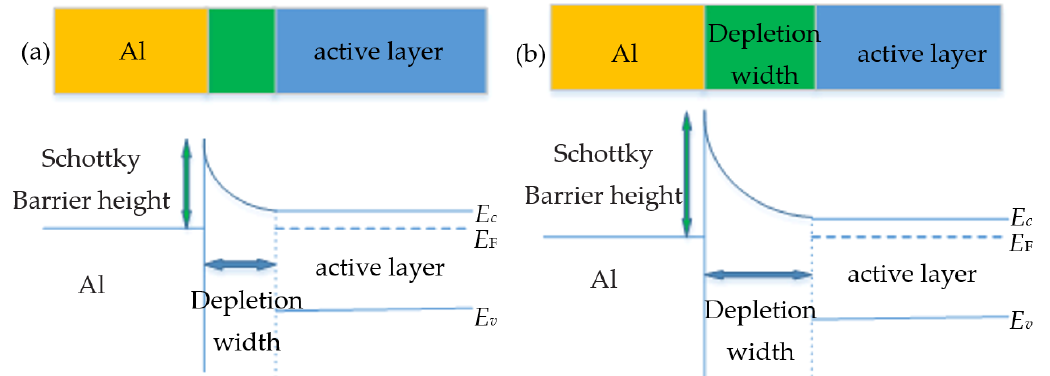
Figure 9. Schematic diagram of the change of Schottky barrier under the applied voltage to form a depletion layer: ( a ) under the positive voltage and ( b ) under the negative voltage.